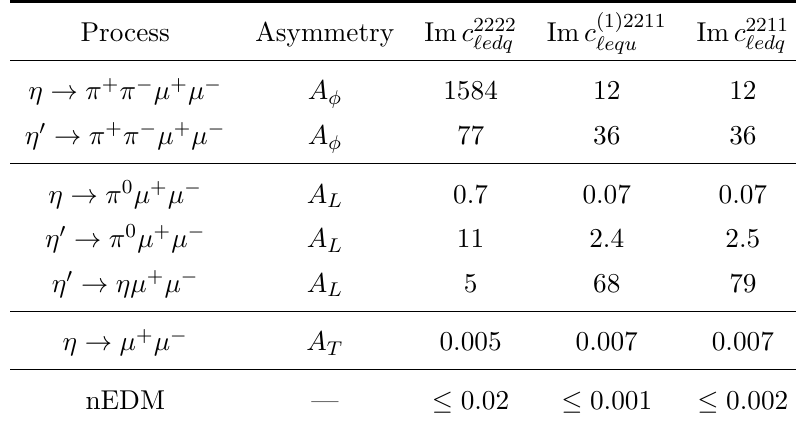
Table 2 . Results for the REDTOP sensitivities to the Wilson coefficients associated with CP - violating SMEFT operators. For completeness we also show the sensitivities from other leptonic and semileptonic channels from refs.